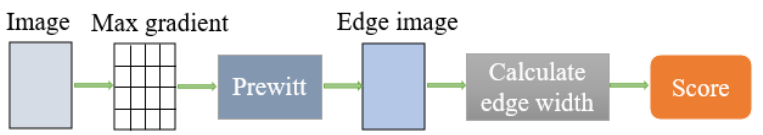
Figure 3. Edge detection results: ( a ) Original image; ( b ) Canny operator; ( c ) Sobel operator; ( d ) Prewitt